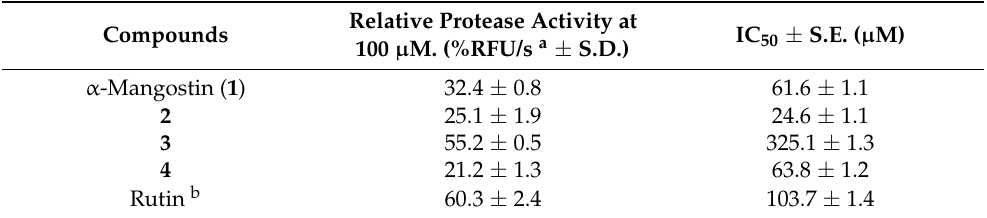
Figure 3. SARS-CoV-2 main protease (3CL pro ) inhibition of α -mangostin ( 1 ) and N -containing α - mangostin analogs ( 2 – 4 ). ( A ) Relative protease activities treated with 100 µM of compounds 1 – 4 and rutin (positive control). ( B ) Activity of 3CL pro at various inhibitor concentrations. Table 5. Inhibitory activity of SARS-CoV-2 3C-like main protease with α -mangostin ( 1 ) and N - containing α -mangostin analogs ( 2 – 4